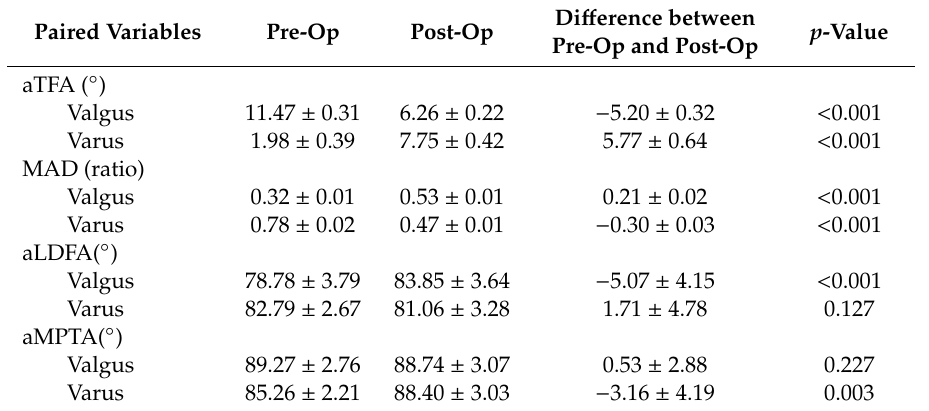
Table 2. Comparison of mean di ff erence between the preoperative and the postoperative indices.